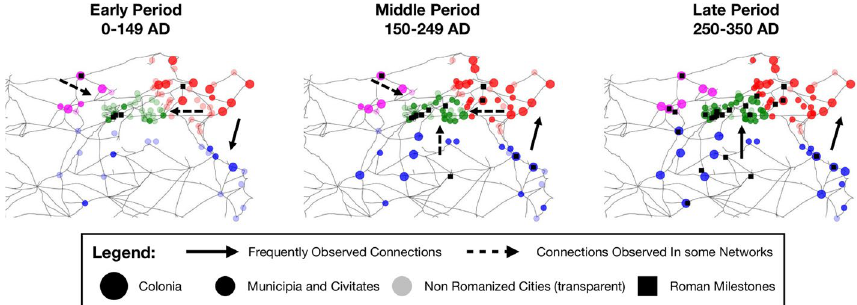
Fig. 5 Validation data and dominant connections of H ∗ . Milestones are marked with black squares and cities with circles (large circles stand for colonias, small circles for municipia and civitates). Cities are colored according to the region they belongs to, were transparent colors indicate that a city has not yet been romanized at that time. Full arrows show the dominant connections of effective current H ∗ that all three solutions have in common. Dashed arrows indicate dominant connections that only some of the solutions A, B, C have. Sources Ancient World Mapping Center (2012); iDAI. geoserver German Archaeological Institute (2022). Licensed under CC BY-NC 3.0. and Open Data